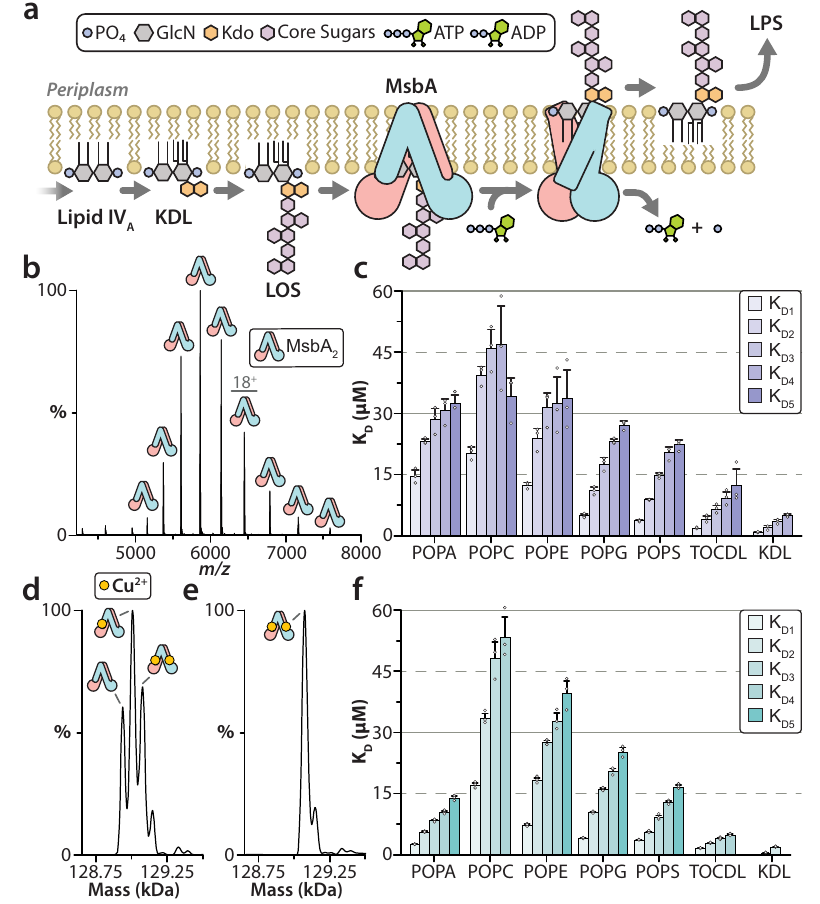
Fig. 1 | Copper(II) binding to MsbA modulates lipid binding af fi nity. a Lipopolysaccharide biosynthesis commences in the cytoplasm to generate lipooligosaccharide(LOS).LOSiscomposedofconservedlipidAstructure(gray),a bisphosphorylated disaccharide of glucosamine, modi fi ed with 3-deoxy-D- manno - oct-2-ulosonic acid (Kdo) sugar (orange) and core oligosaccharide (purple), of which isdependent on the bacteria.MsbA,powered by the hydrolysisof ATP, fl ips cytoplasmic LOS from inner to outer lea fl et of the inner membrane, an essential stepinLPSbiogenesis.The fl ippedLOSistransportedtotheoutermembranealong withadditionalmodi fi cationstobecomeLPS. b Nativemassspectrumofoptimized